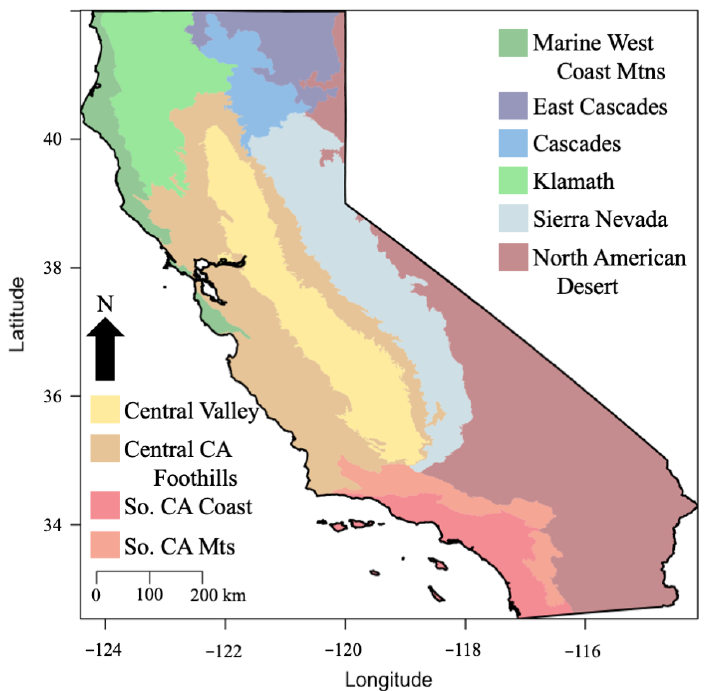
Figure 1. Ecoregions of California, including the southern California Mountains (SCM), southern California Coast (SCC), Central California foothills (CCF), Central Valley (CV), North American Desert (NAM), Sierra Nevada (SN), Klamath (K), Cascades (C), East Cascades (EC), Marine West Coast Mountains (MWCM), and North American Desert (NAD).